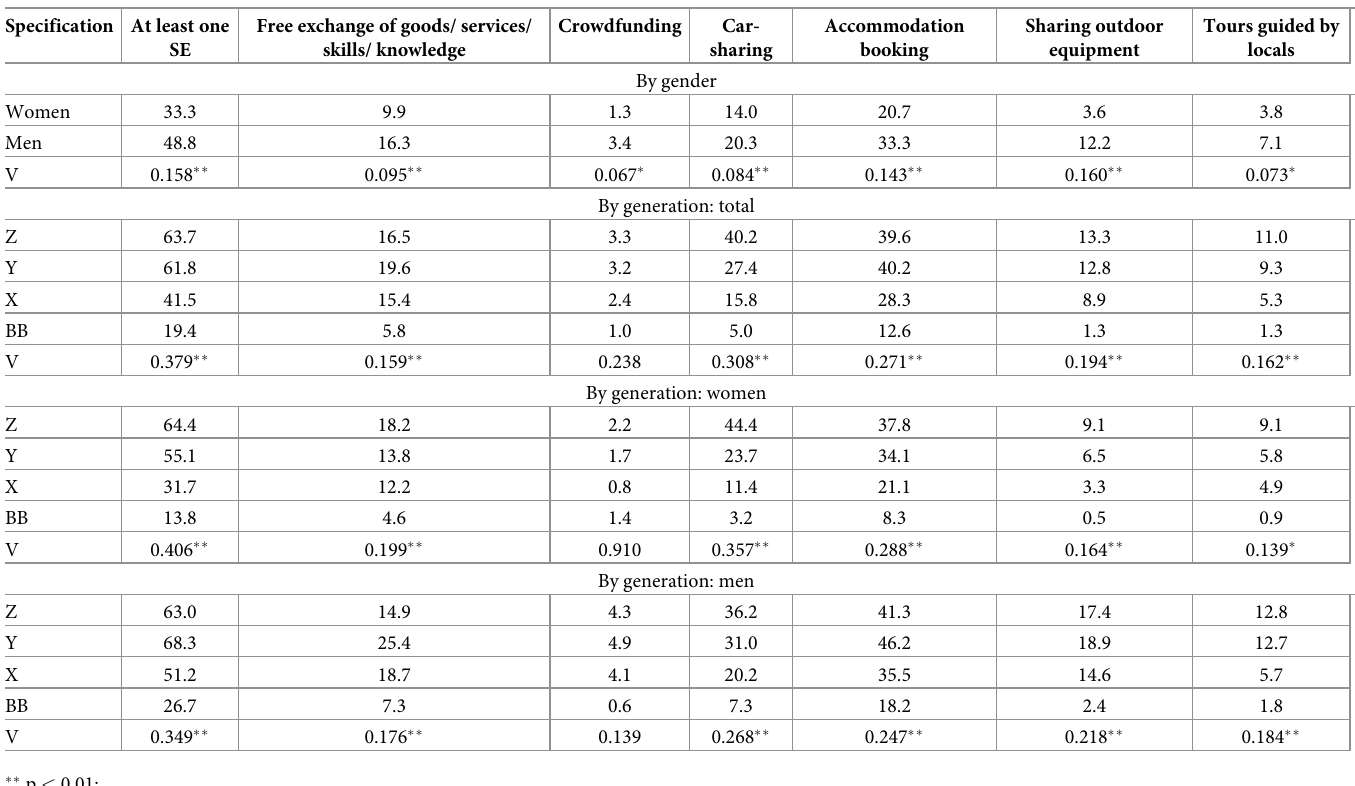
Table 5. Sharing platforms’ services used in Poland by generation and gender